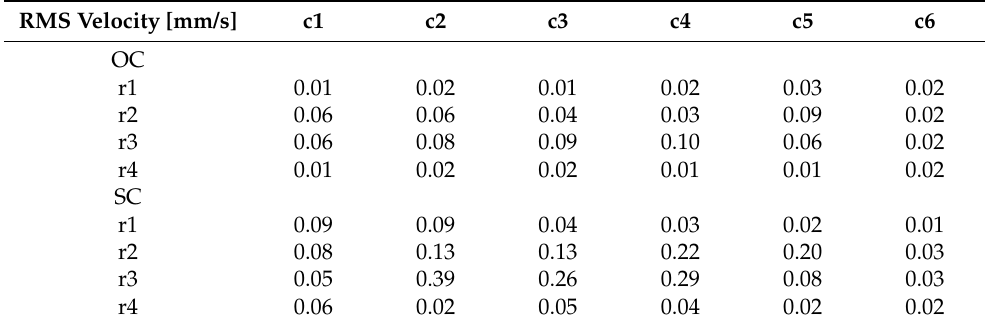
Table 4. RMS values of the vibration velocity on the transformer tank cover in the open-circuit (OC) and short-circuit (SC)